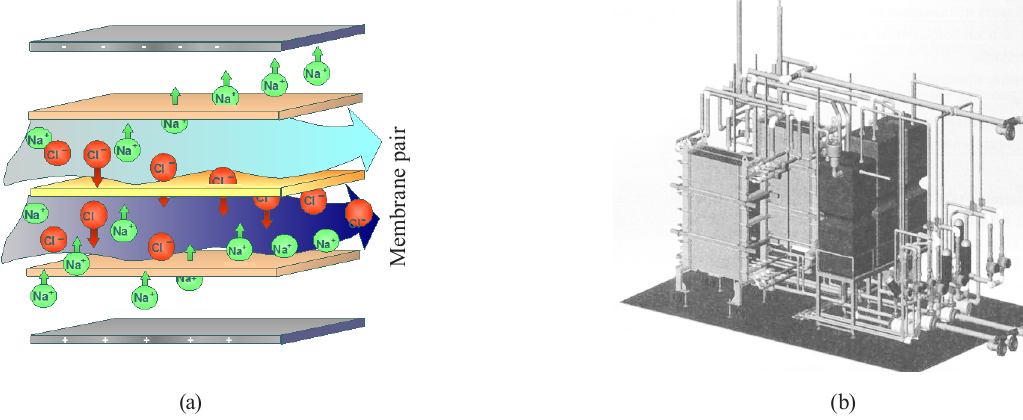
Figure 3 Schematic diagram of whey demineralisation (a) and a module of Istok electrodialysis installation (b)